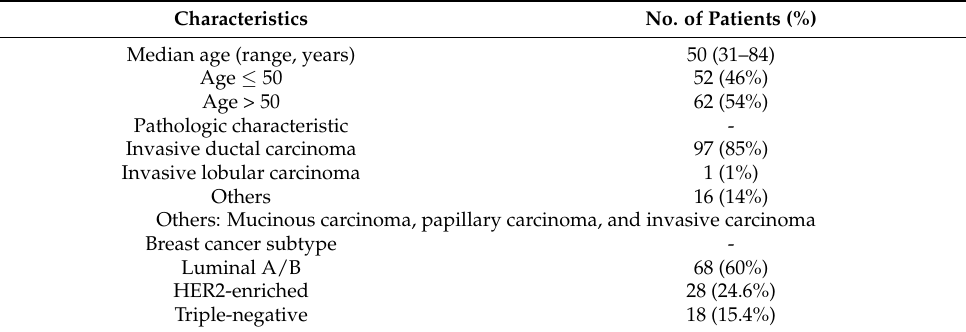
Table 1. Clinicopathological characteristics in the